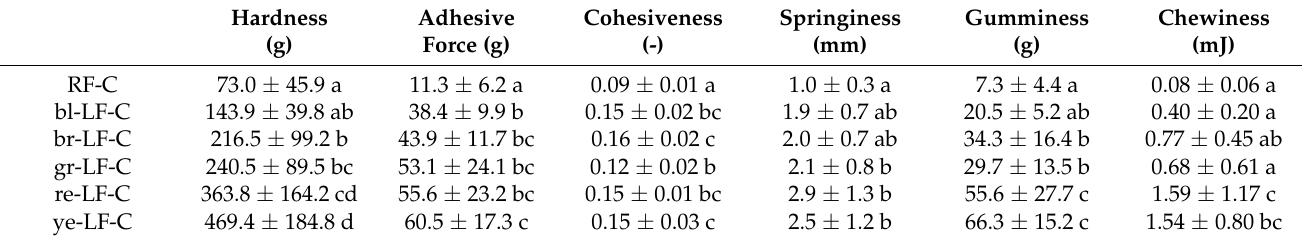
Table 10. Textural properties of rice control and lentil cookies.